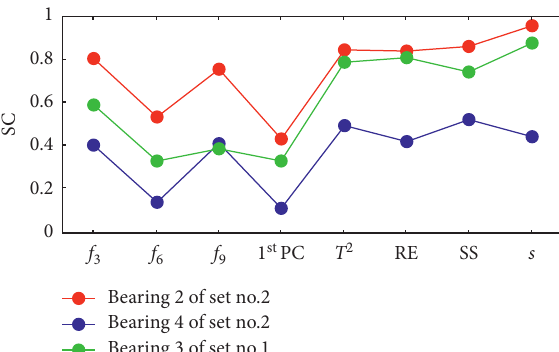
Figure 8: Spearman coefficient comparison of different HIs for different bearing failure on its whole life time.